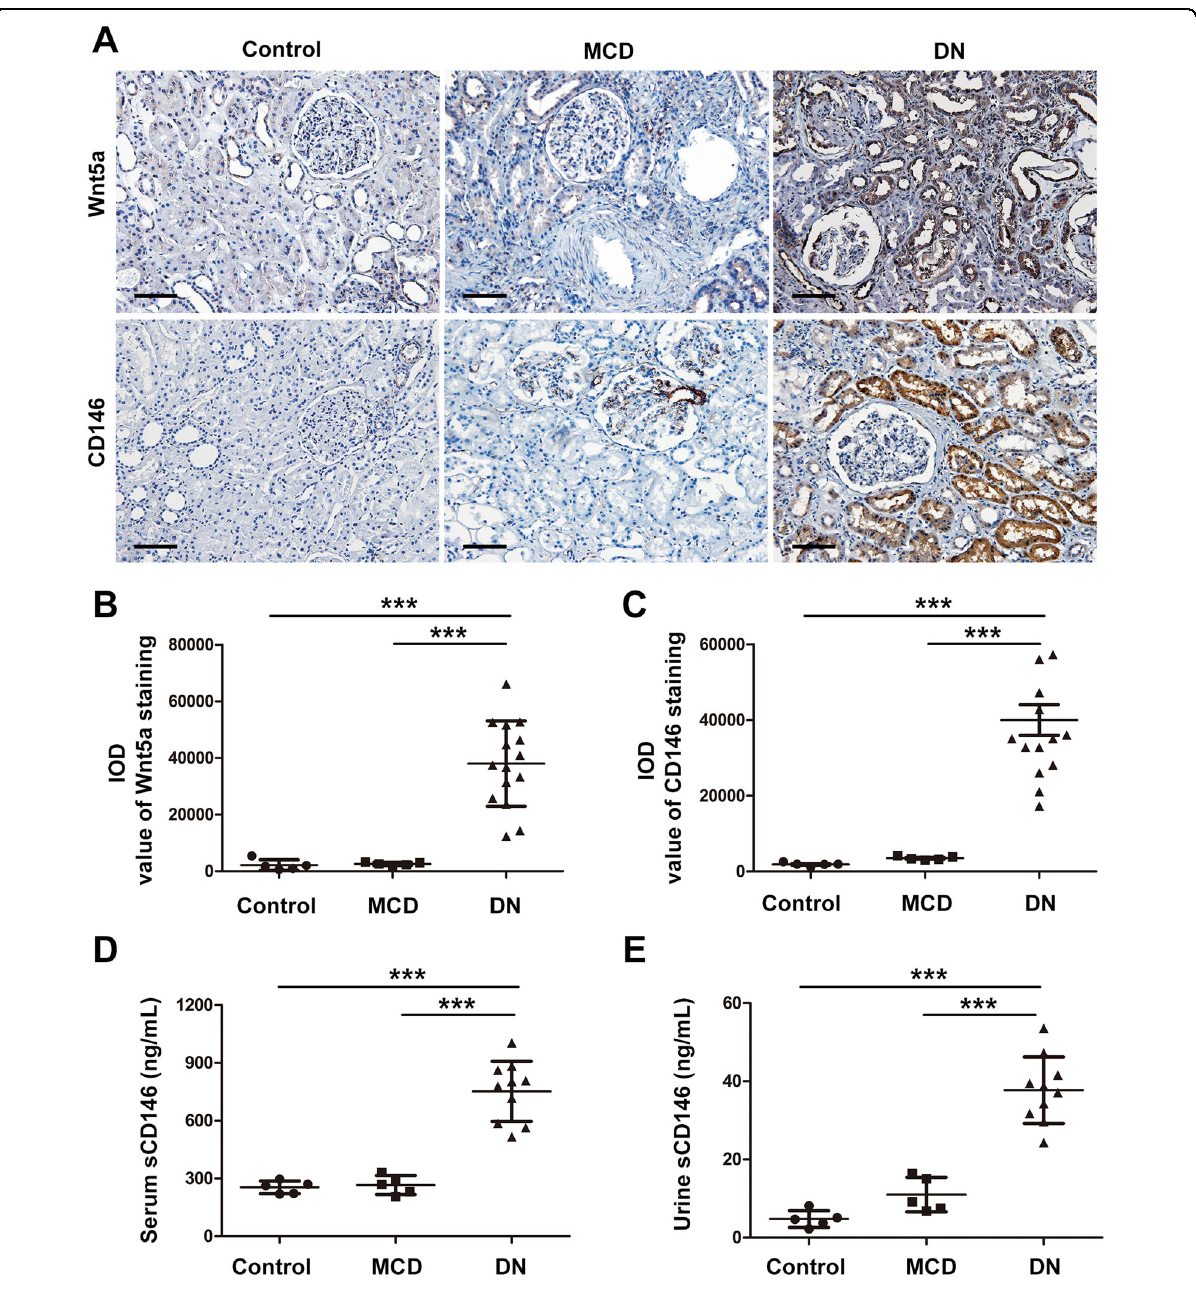
Fig. 1 The expression levels of Wnt5a and CD146 were upregulated in diabetic neuropathy (DN) patients. A Representative immunostaining of Wnt5a and CD146 on normal kidney sections of nephrectomy samples ( n = 5) and kidney biopsy samples of patients with minimal change disease (MCD) ( n = 5) and DN ( n = 15). Original magni fi cation, ×200; scale bar, 100 μ m. B Quantitative analysis of Wnt5a staining in kidney sections from each group according to the average integrated optical density (IOD). *** P < 0.001. C Quantitative analysis of expression of CD146 staining on kidney sections of each group by the average IOD. *** P < 0.001. D , E The concentration of soluble CD146 (sCD146) in serum and urine samples of each group. *** P < 0.001. Immunostaining was performed in duplicate. Signi fi cant differences were determined by unpaired two-tailed t